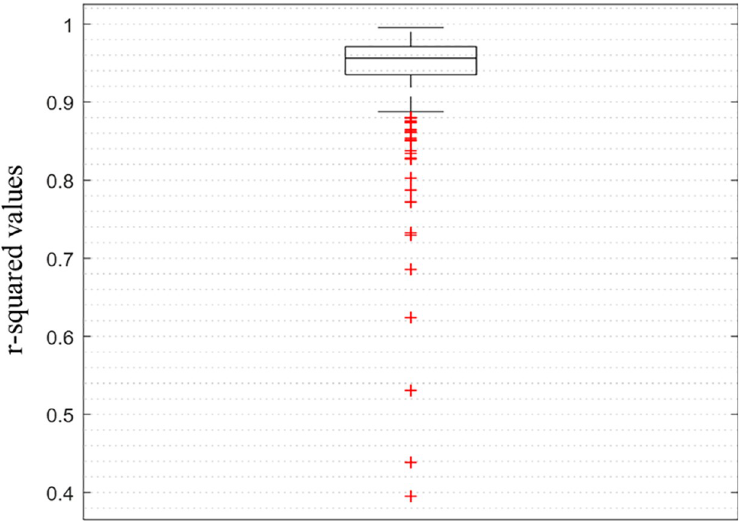
Fig 7. Box-plot of the R 2 values of all 300 simulated faces for the precision of the algorithm in localizing the FA values. FA (a) and the calculated asymmetry heat-map (b). The correlation between the true and cal- culated FA values for all of the vertices of a face was calculated for all 300 of the simulated faces and the R-squared values are represented by the box-plot in Fig 7.